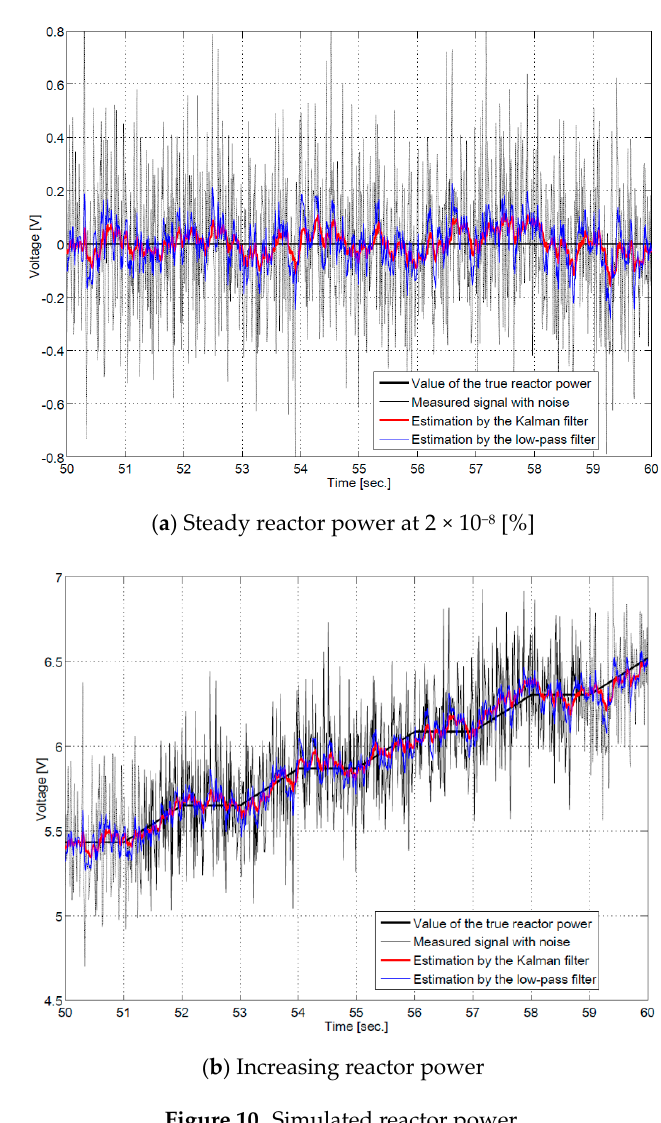
Figure 10. Simulated reactor power.